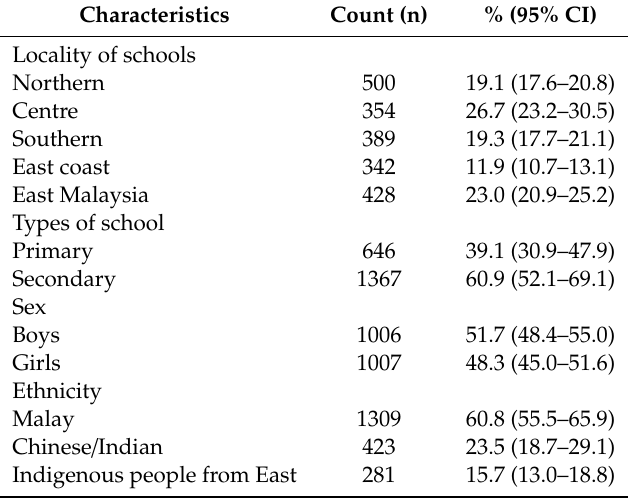
Table 1. Socio-demographic characteristics and dietary habits of the